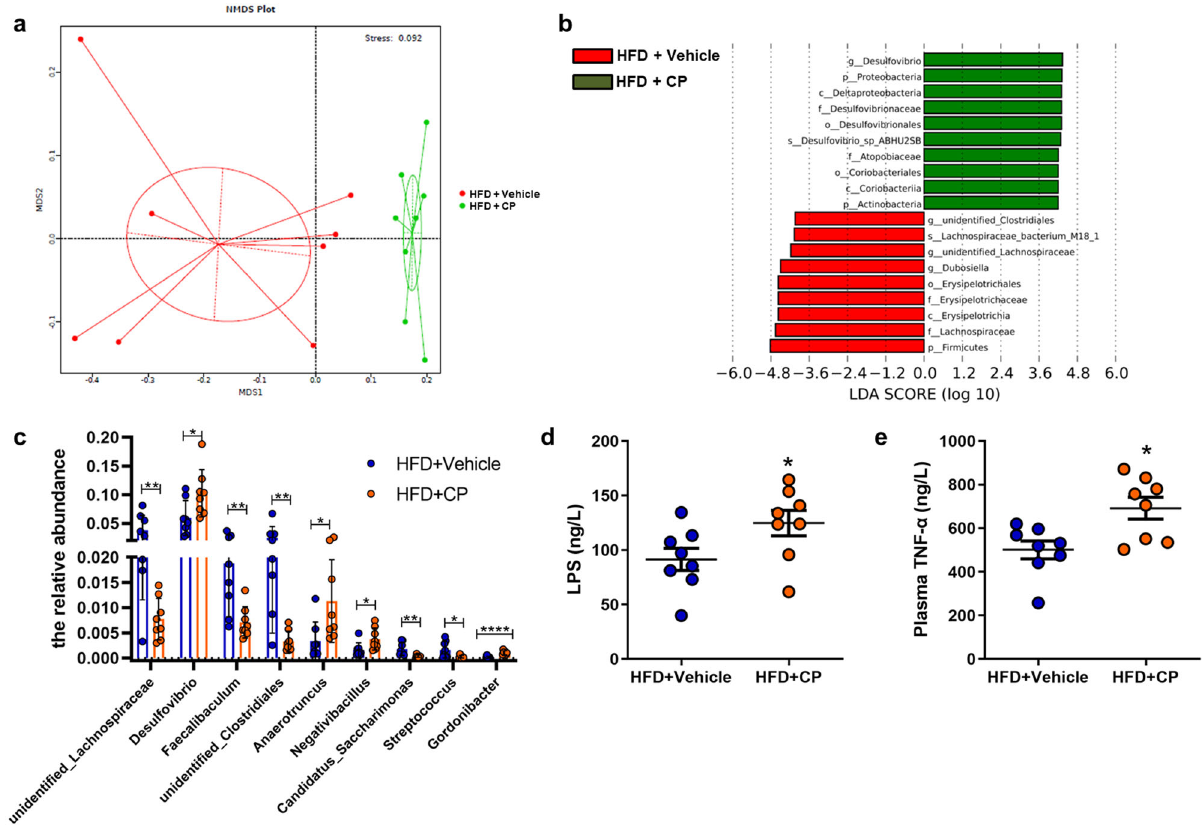
Fig. 4 Changes of the gut bacterial community in the live C. parpsilosis -treated and antifungal pretreated HFD mice. a Nonmetric multidimensional scaling (NMDS) analysis; b linear discriminant analysis (LDA) scores derived from LEfSe analysis; c T.TEST analysis at the level of genus; d plasma lipopolysaccharide (LPS); e plasma TNF- α . HFD + vehicle, high-fat diet-fed and fungi-free mice treated with PBS; HFD + CP, high-fat diet-fed and fungi-free mice treated with the live C. parapsilosis . Data are presented as the mean ± SEM. N = 8 mice per group. * p < 0.05; ** p < 0.01; **** p <